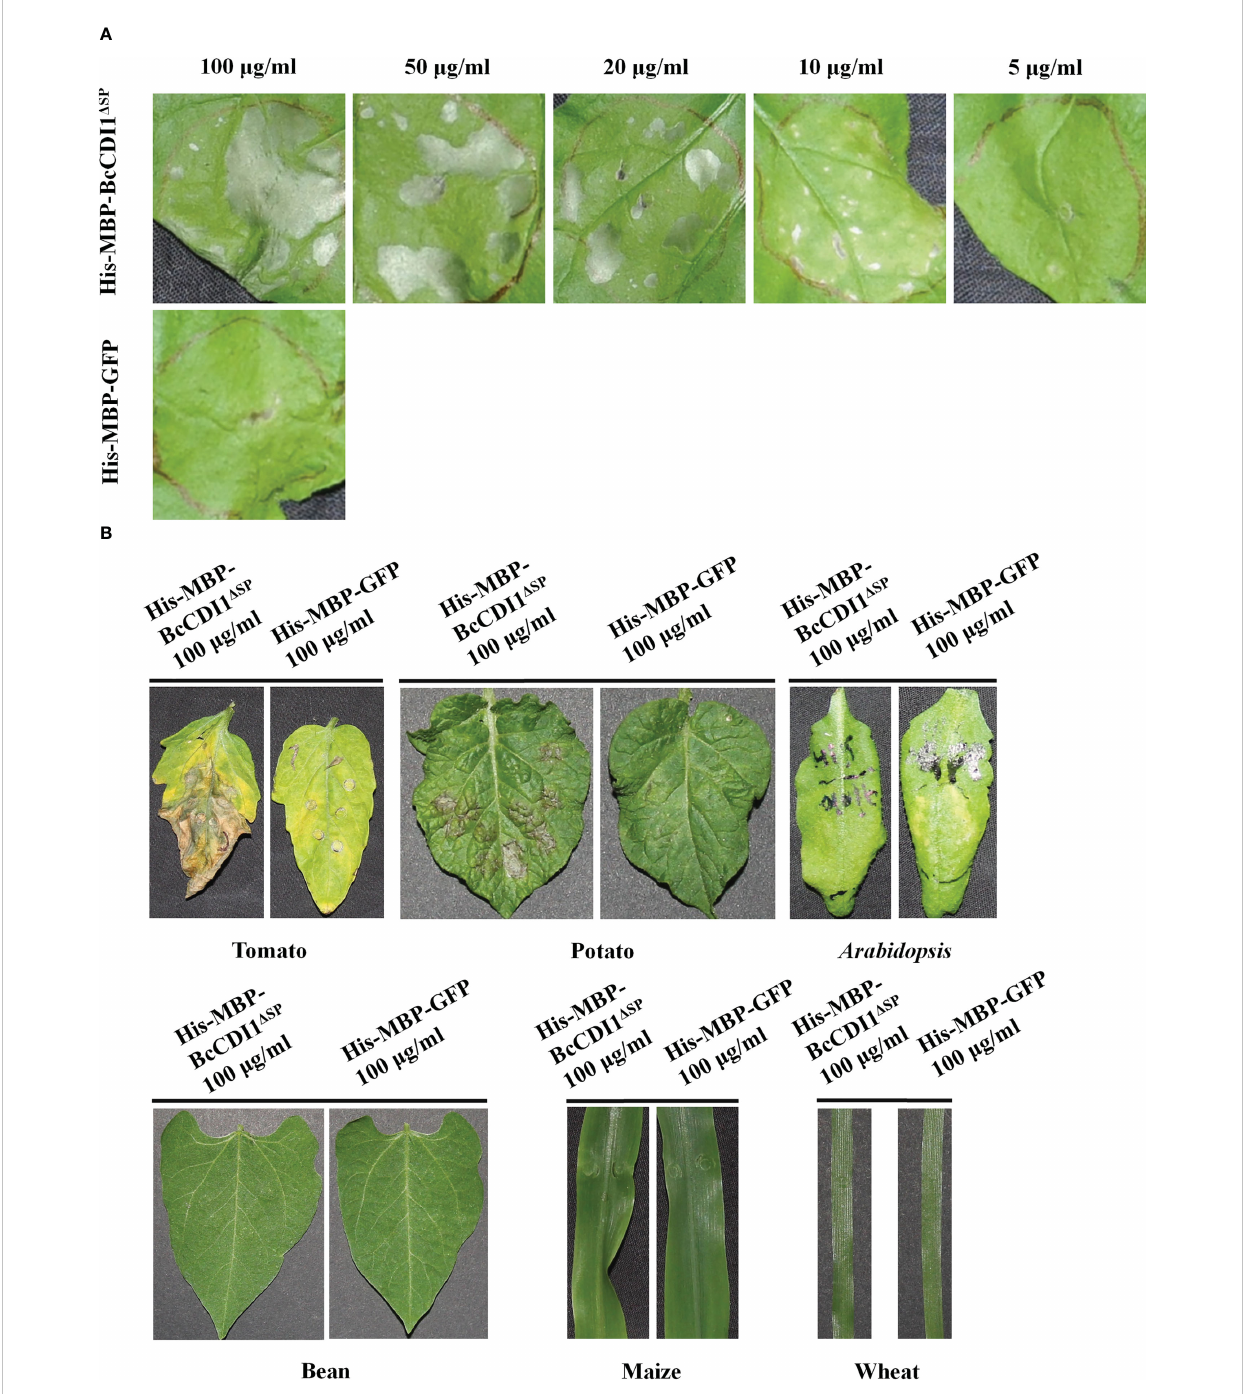
FIGURE 3 His-MBP-BcCDI1 D SP protein induces necrosis in tobacco, tomato, and potato. Proteins were produced in Escherichia coli , puri fi ed, and suspended in PBS. (A) Response of Nicotiana benthamiana leaves in fi ltrated with different concentrations of His-MBP-BcCDI1 D SP at 5 days after treatment. (B) Response of tomato, potato, Arabidopsis , bean, maize, and wheat leaves in fi ltrated with 100 m g/ml of protein solution at 5 days after treatment. The His-MBP-GFP protein was used as the